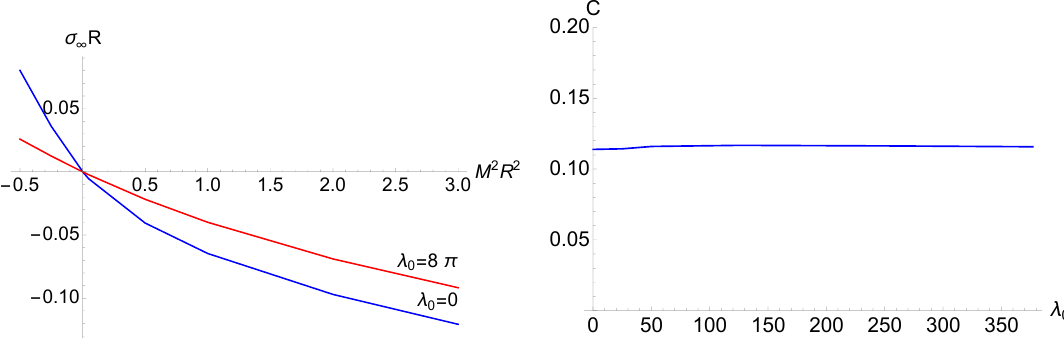
Figure 8 . Left : (cid:27) 1 as a function of M 2 for both the free and interacting theories. In both cases ren we identify linear behaviour at small M ren . Right : C ( (cid:21) 0 ) as a function of (cid:21) 0 is almost a constant and close to the Bunch-Davies value 1 = 8 = 0 : 125. The plot obtained was for M 2 R 2 = 0 : 1. ren In the large mass limit the Bunch-Davies mean (cid:12)eld yields linear dependence on the